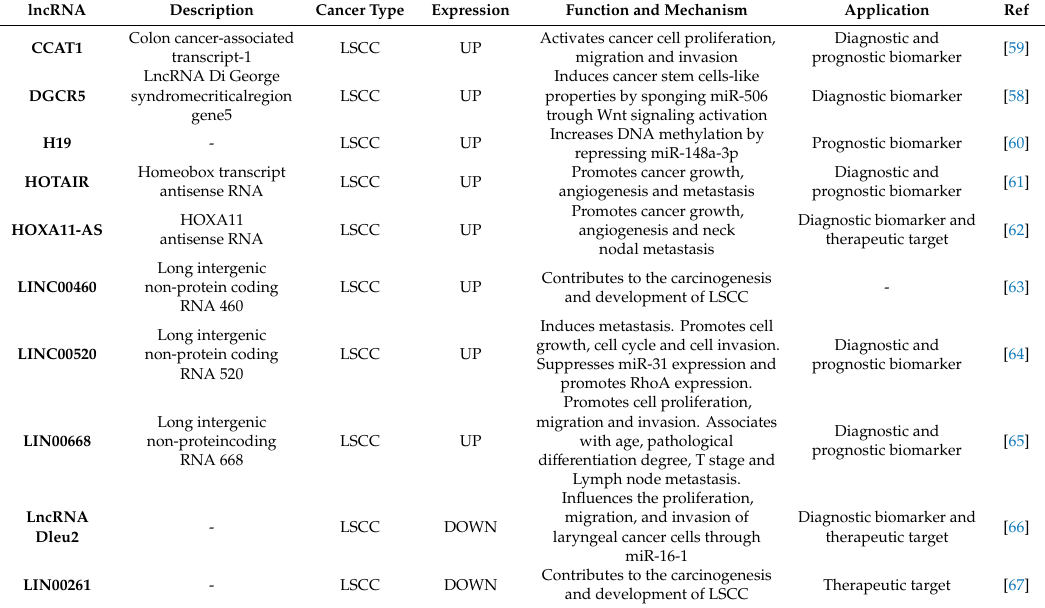
Table 2. LncRNAs in